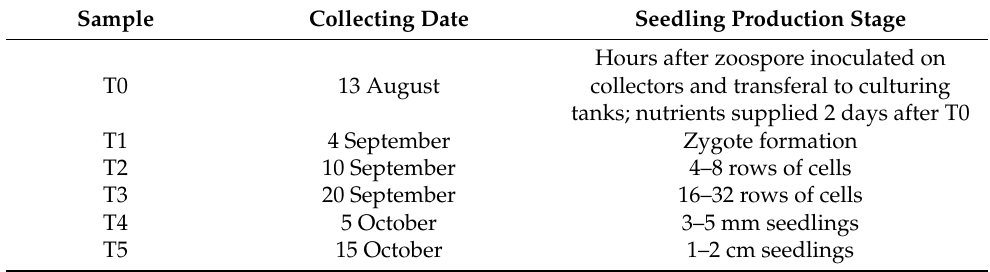
Table 1. Seawater sampling and associating